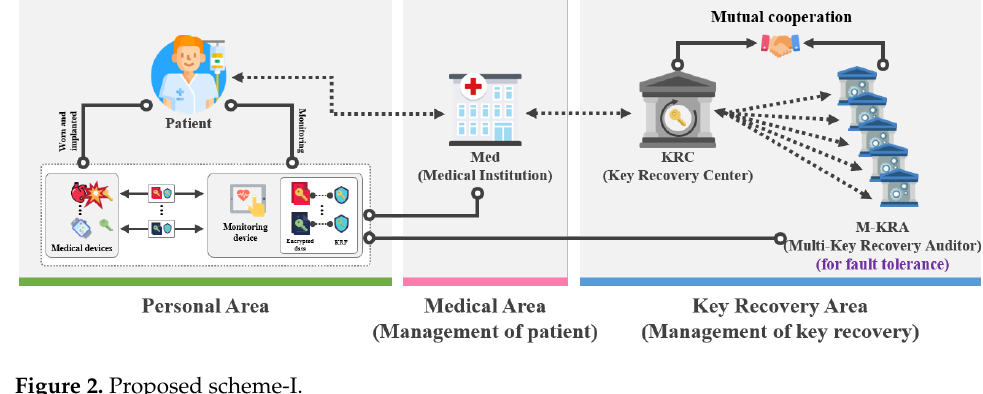
Figure 2. Proposed